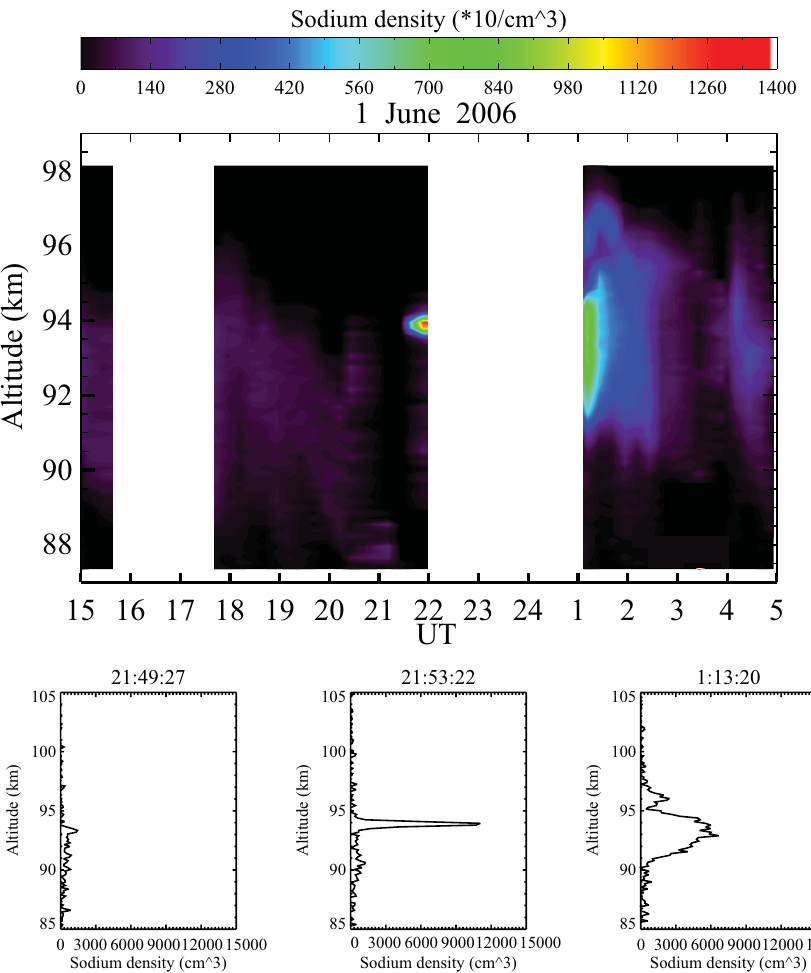
Fig. 3. The Na number density measured on 1–2 June 2006 with the Weber Na Lidar at ALOMAR and profiles of the Na layer at three different